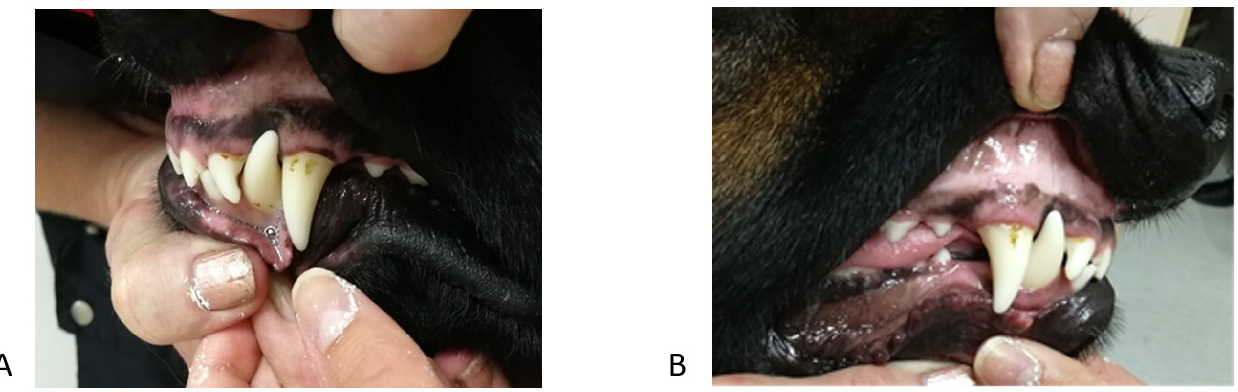
Figure 3. First case. Occlusion after treatment. ( A ) left side, ( B ) right side.